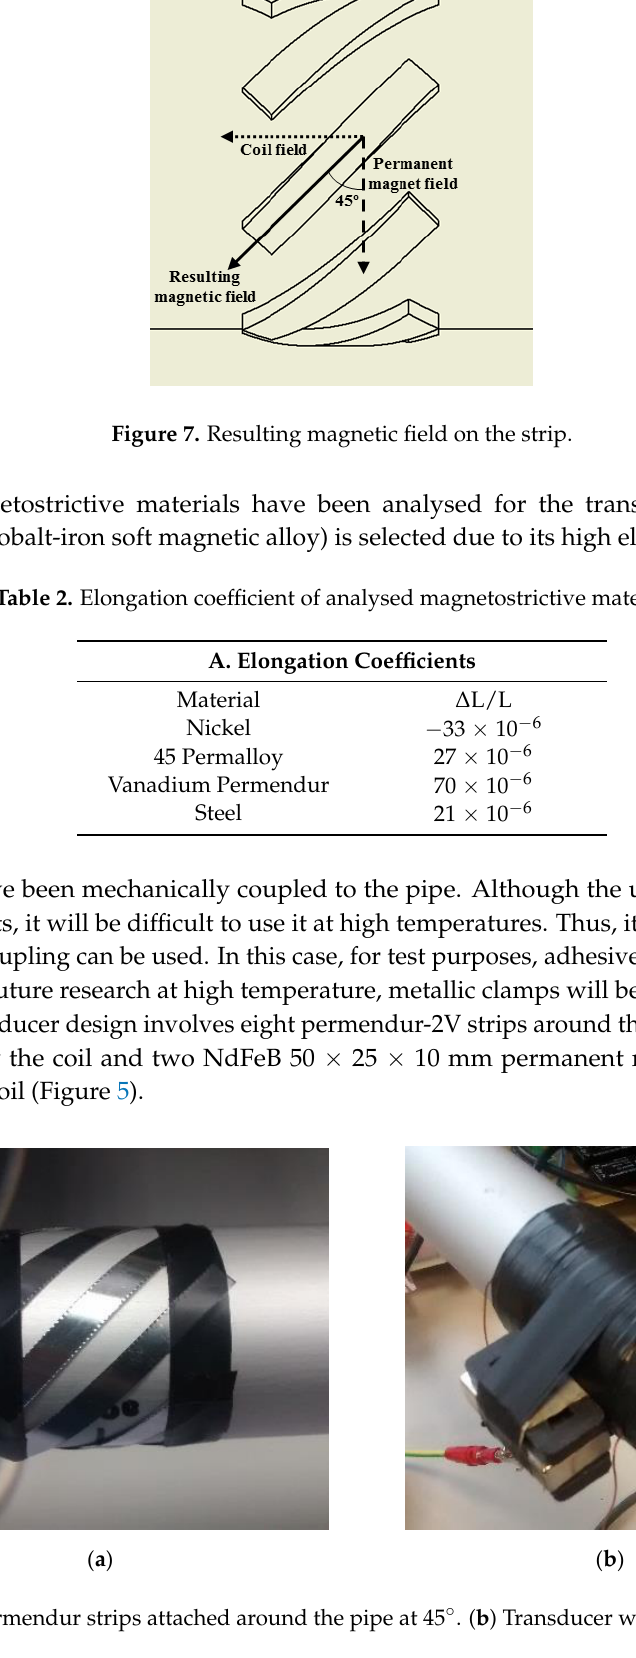
Figure 8. ( a ) Permendur strips attached around the pipe at 45°. ( b ) Transducer with coil and magnets.